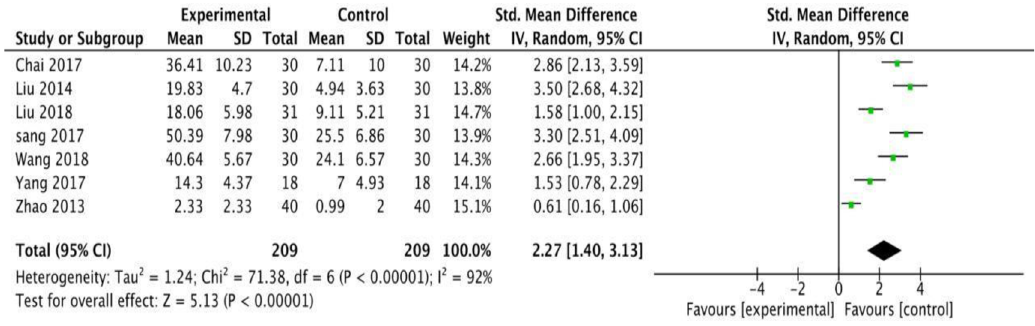
Fig 10. Meta-analysis of fire acupuncture versus acupuncture for spasticity after stroke in FMA.